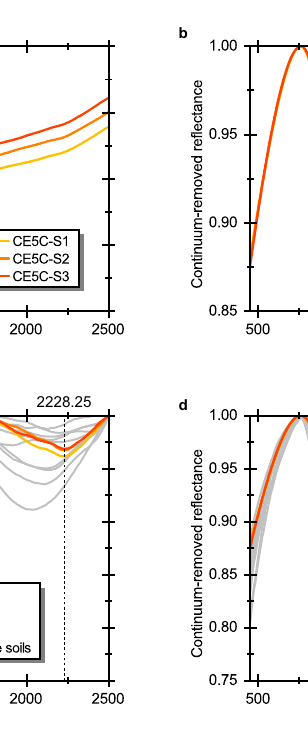
comparison between CE-5 and LSCC mare soil samples. d Spectra comparison between CE-5 and LSCC highland soil samples. Dashed lines and numbers in c , d represent the average 1 μ m and 2 μ m band centers of three CE-5 soil